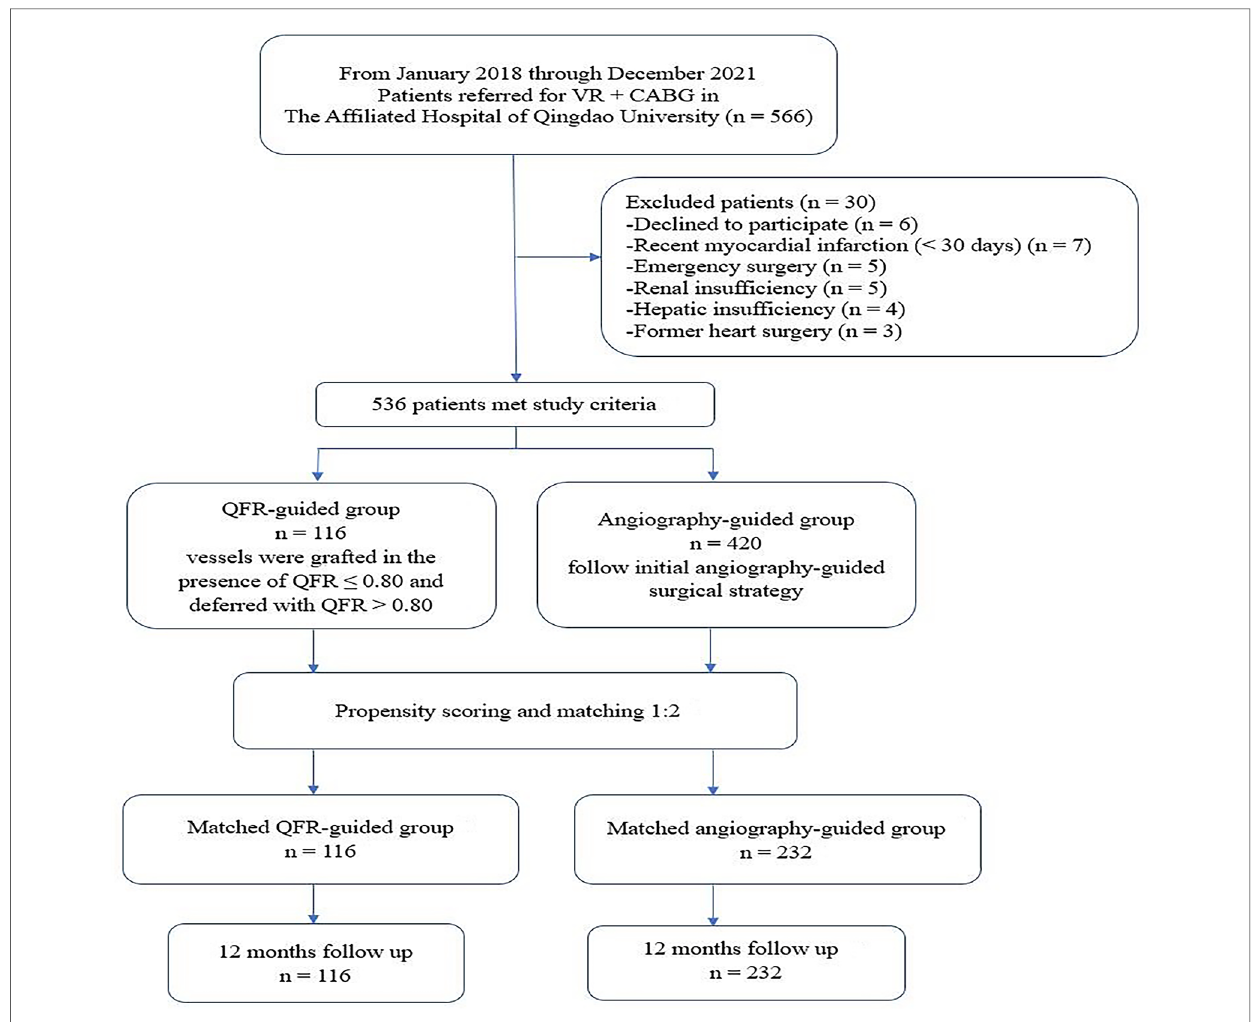
FIGURE 1 Study fl ow chart. VR+CABG, heart valve surgical replacement combined with coronary artery bypass graft; QFR, quantitative fl ow